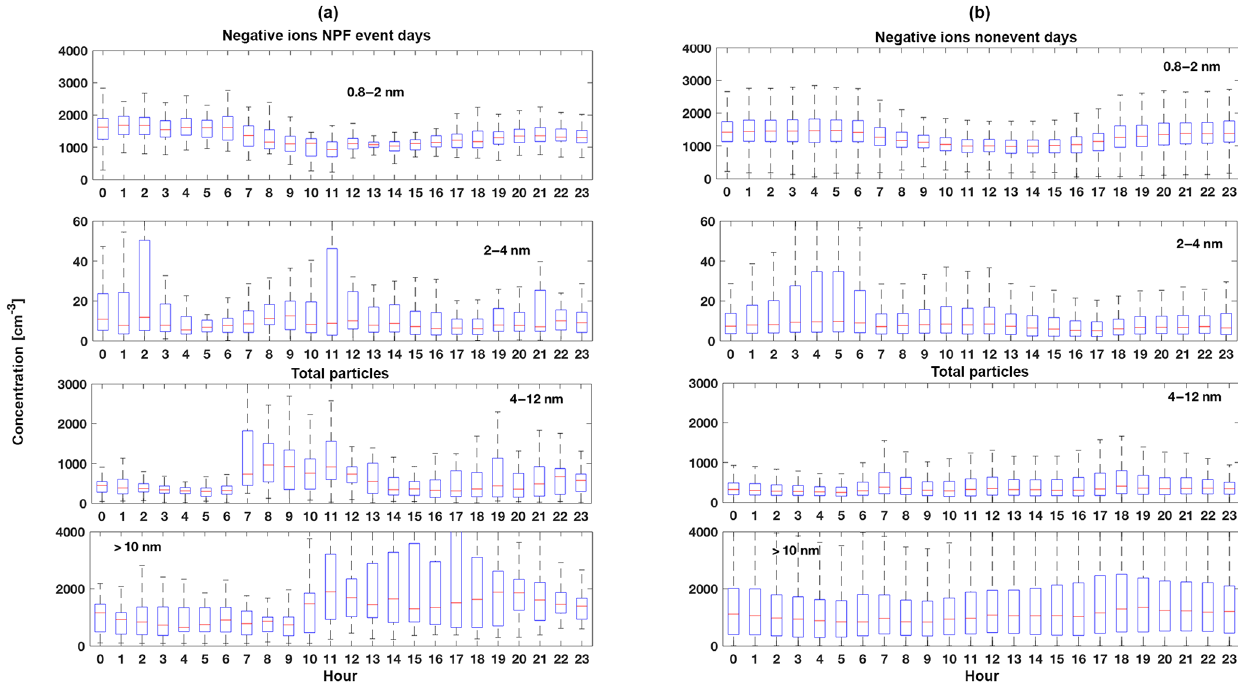
Figure 9. The median diel cycles of cluster ions (0.8–2nm), intermediate ions (2–4nm), large (4–12nm) neutral particles, and total particles ( > 10nm) for new particle formation event days (a) and nonevent days (b) are shown. The boxes show the 25th–75th percentiles and the whiskers are 1 . 5 × IQR (interquartile range); data points beyond the whiskers are considered outliers.